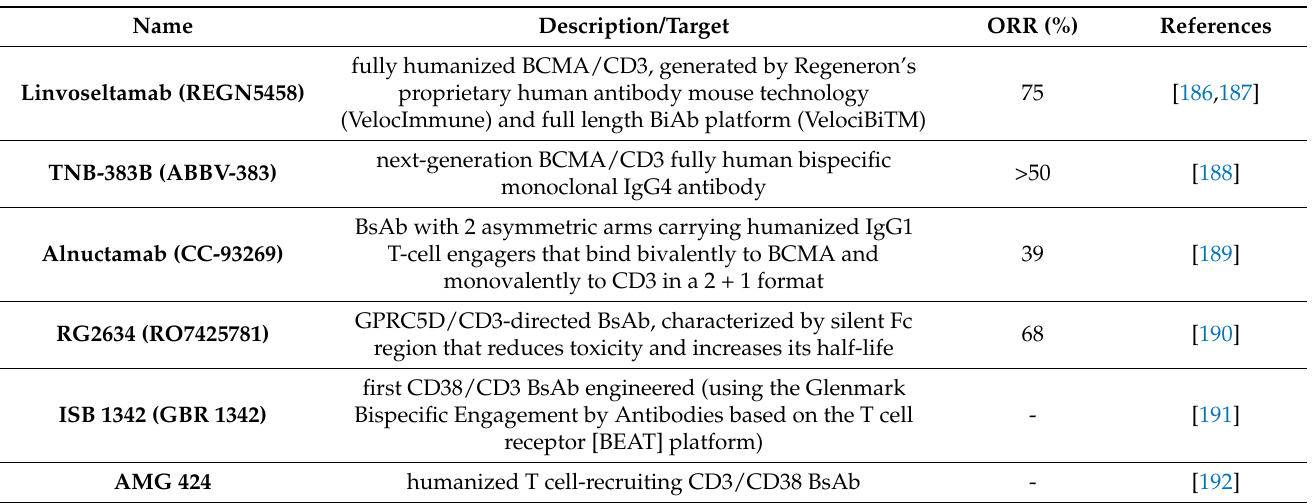
Table 4. Other BsAbs in